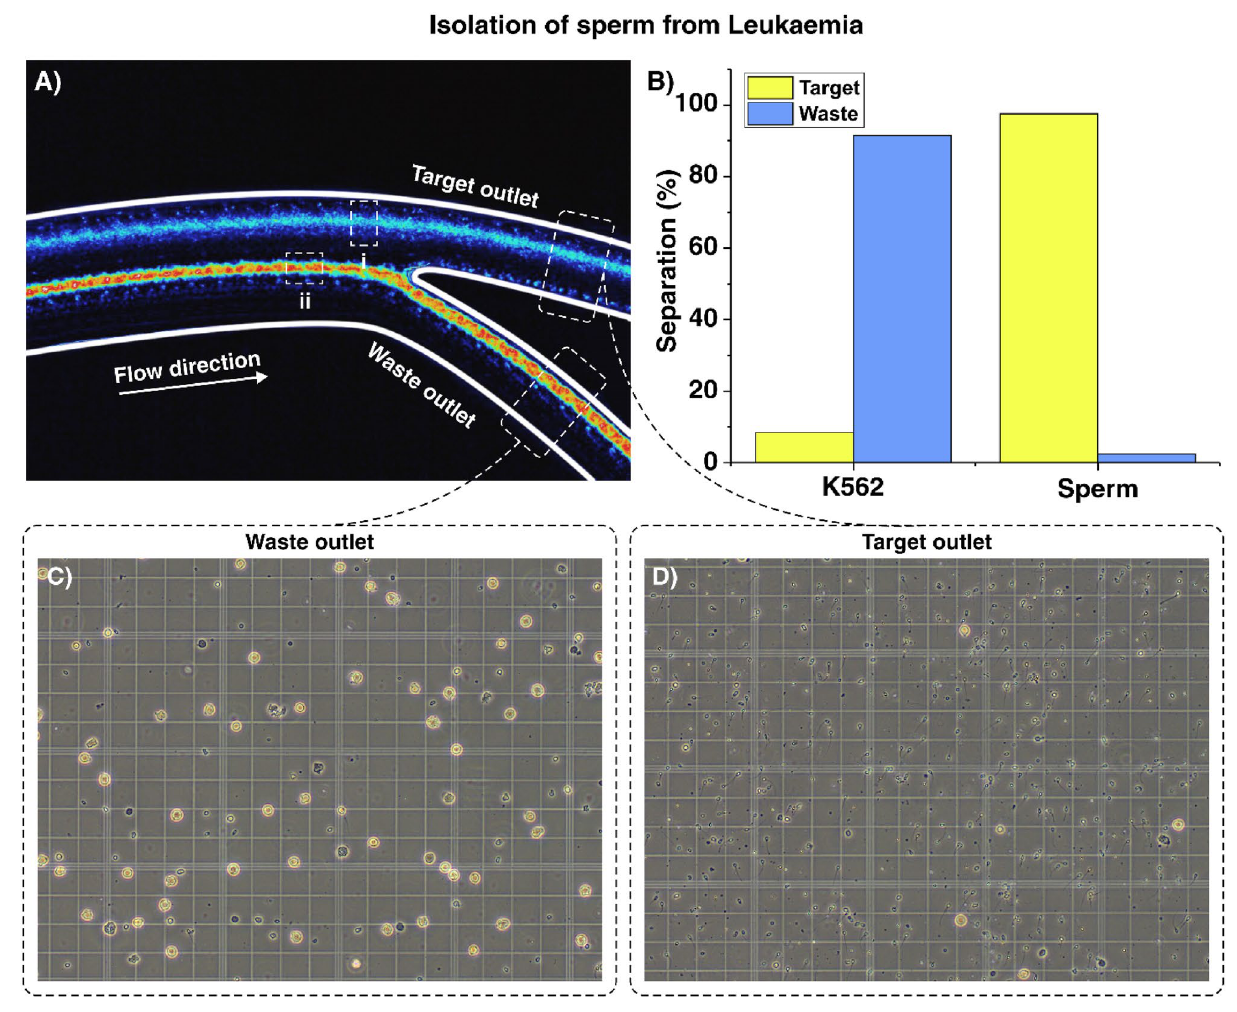
Figure 5. Separation of sperm from K562 leukemic cells ( A ) high speed video stack of outlet focusing where (i) shows the tight focusing band of sperm (flow rate of 1.1 mL/min) and (ii) shows the focusing band of K562. ( B ) Separation efficiency where N = 5 and separation efficiency is presented as the average percentage efficiency ± standard deviation. ( C , D ) Waste and target fractions,